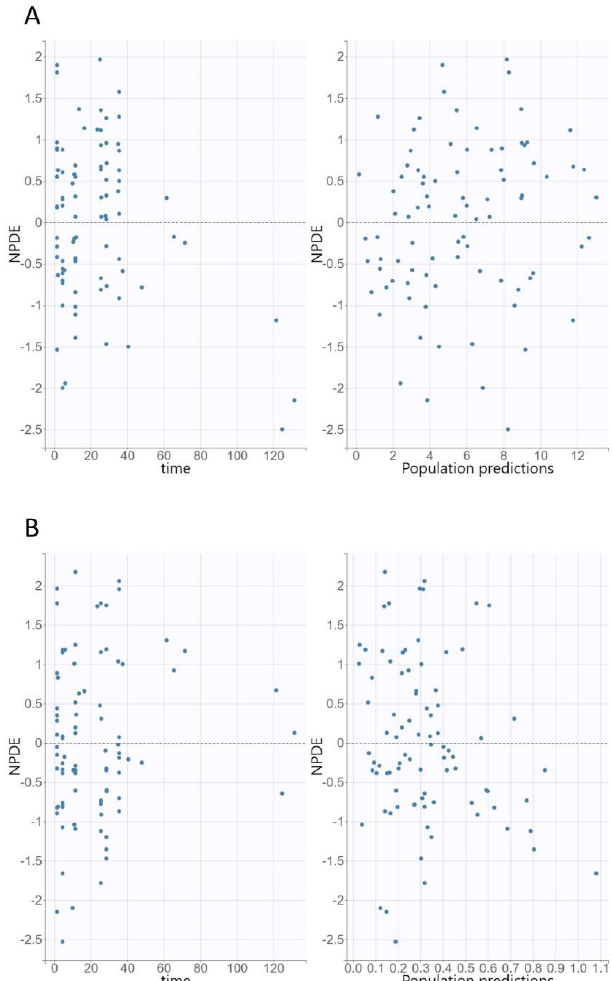
Figure 3. Normalized prediction distribution errors (NPDE) for ciprofloxacin ( A ) and desethylene ciprofloxacin ( B ) versus time and population predictions.